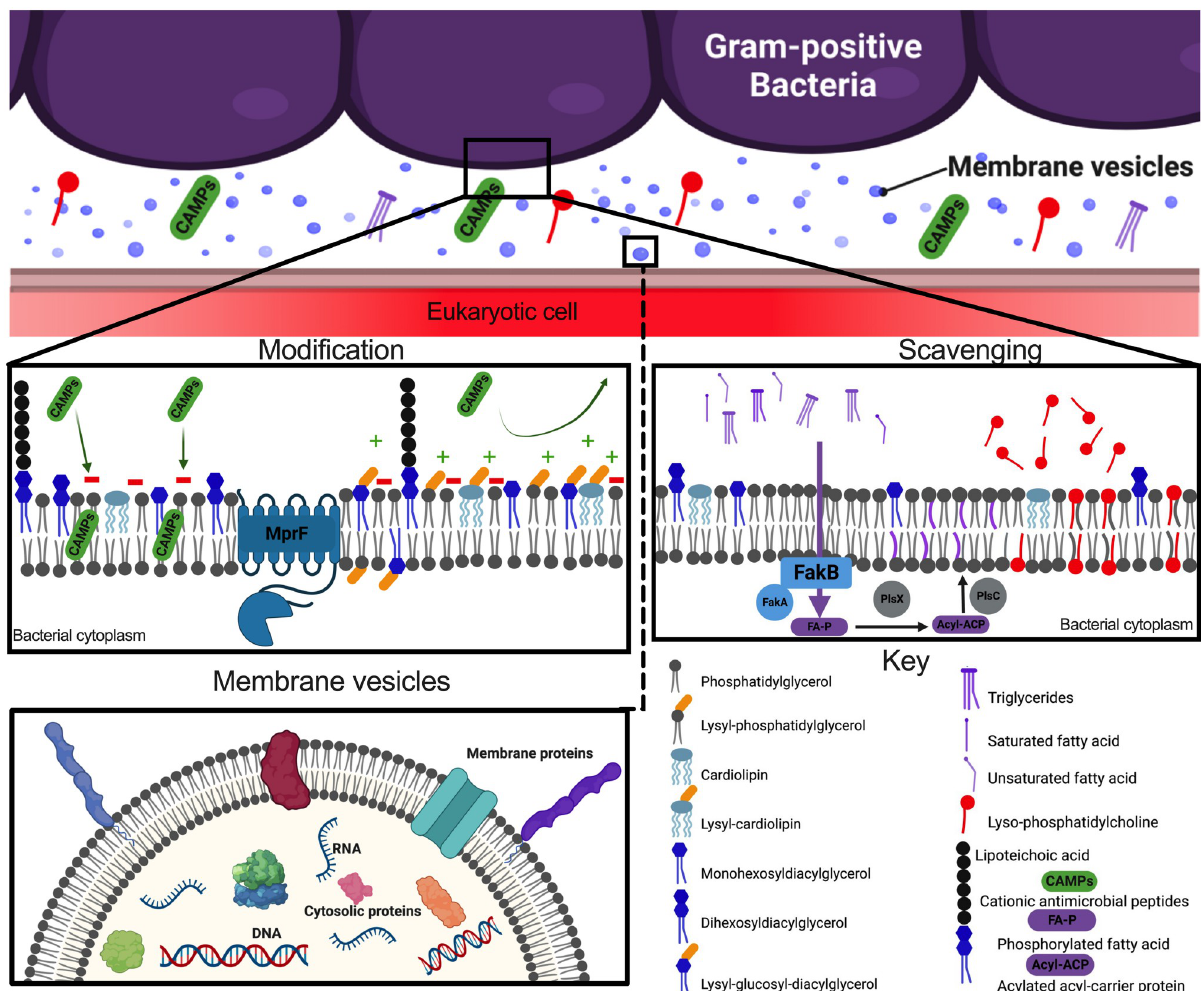
Fig 1. Gram-positive membrane lipids at the host–pathogen interface. Gram-positive bacteria utilize the cellular membrane during host–pathogen interactions. Modification of lipids protects against antimicrobials, scavenging host lipids and fatty acids provides protection against membrane stress and provides a form of membrane mimicry, and MVs carry a variety of cargo from the bacterial cell into the surrounding environment to interact with host cells. MprF; multiple peptide resistance factor, FakB; fatty acid kinase B, FakA; fatty acid kinase A, PlsX; phosphate acyltransferase, PlsC; 1-acyl-sn- glycerol-3-phosphate acyltransferase. Figure made by